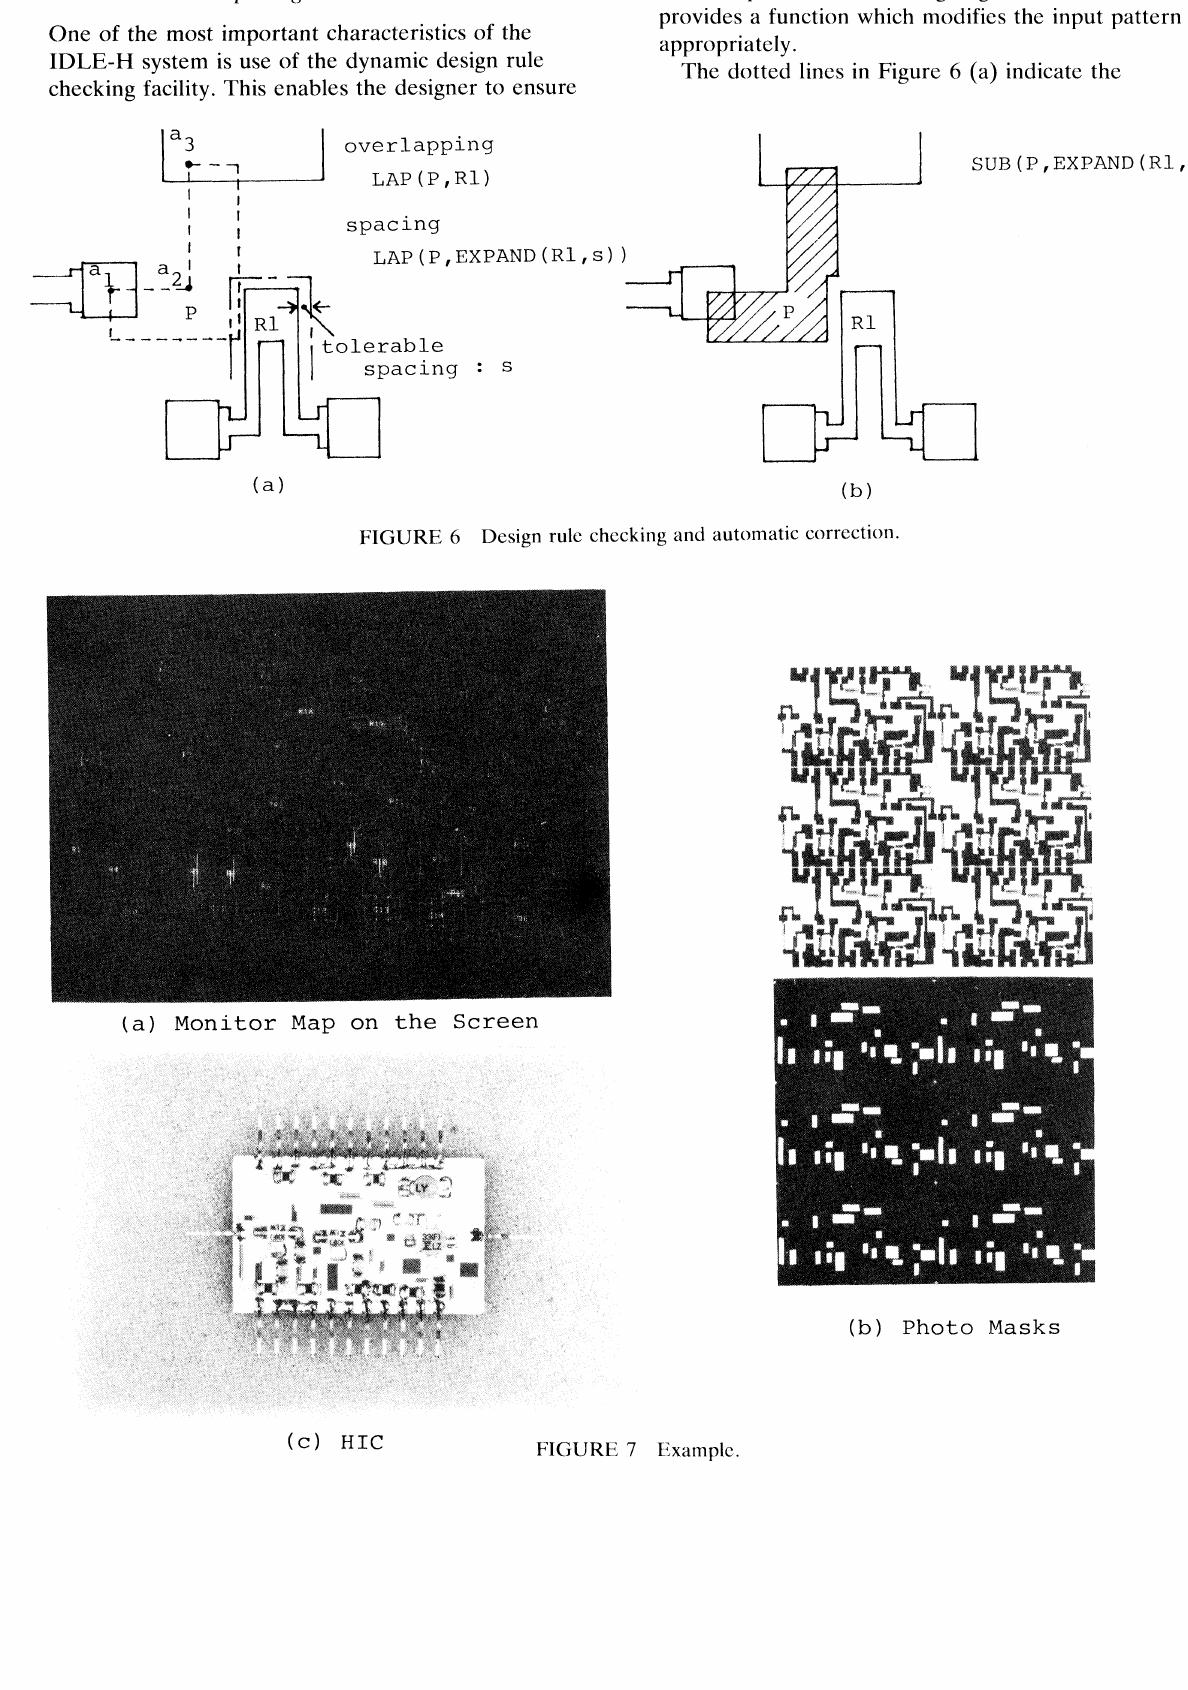
FIGURE 6 Design rule checking and automatic